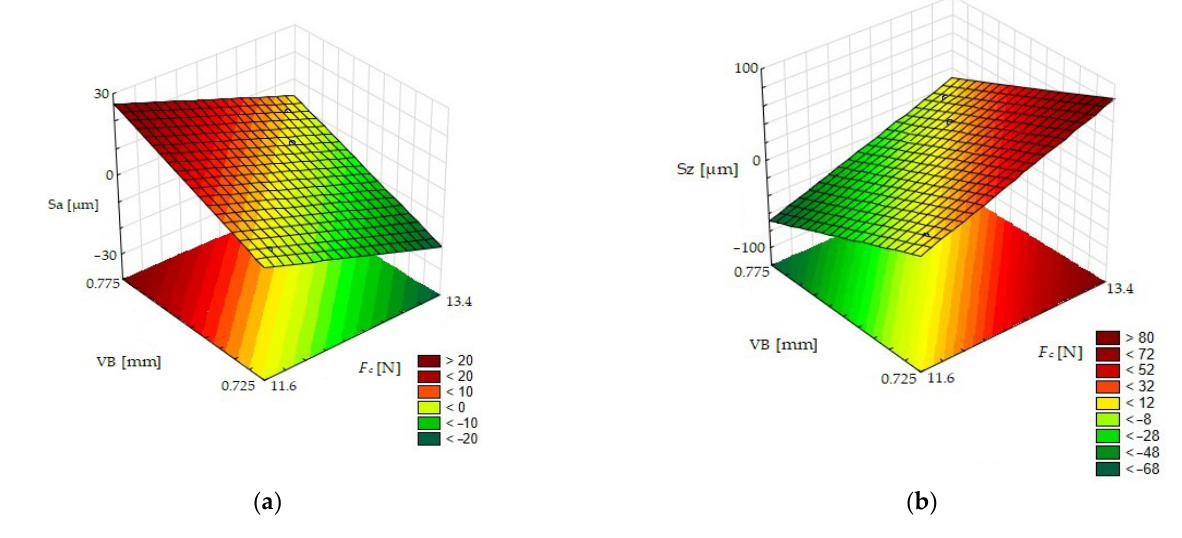
Figure 20. The surface roughness of MMC after turning as a function of tool’s wear VB and cutting force F c : ( a ) Sa parameter and ( b ) Sz parameter.